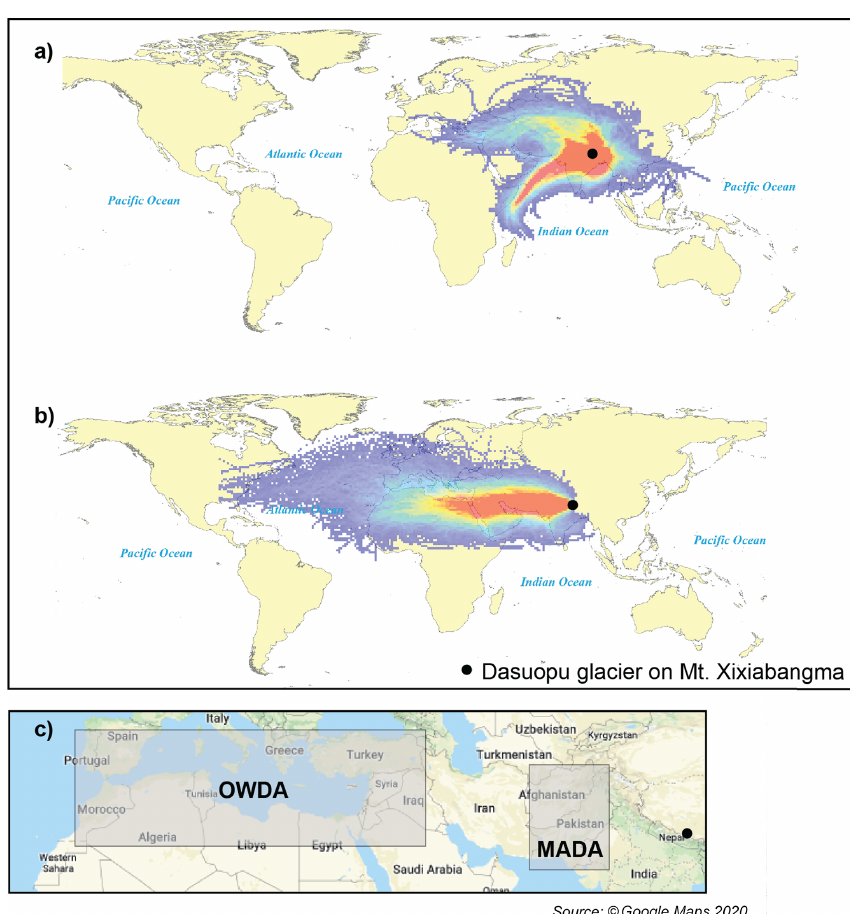
Figure 5. Frequency of back trajectories for air masses arriving at Mt. Xixiabangma in (a) July and (b) January. Red and blue indicate higher-frequency and lower-frequency air mass flow paths, respectively. The area included in the Old World Drought Atlas (OWDA; Cook et al., 2015) and the Monsoon Asia Drought Atlas (MADA; Cook et al., 2010) reconstructions is indicated (c)